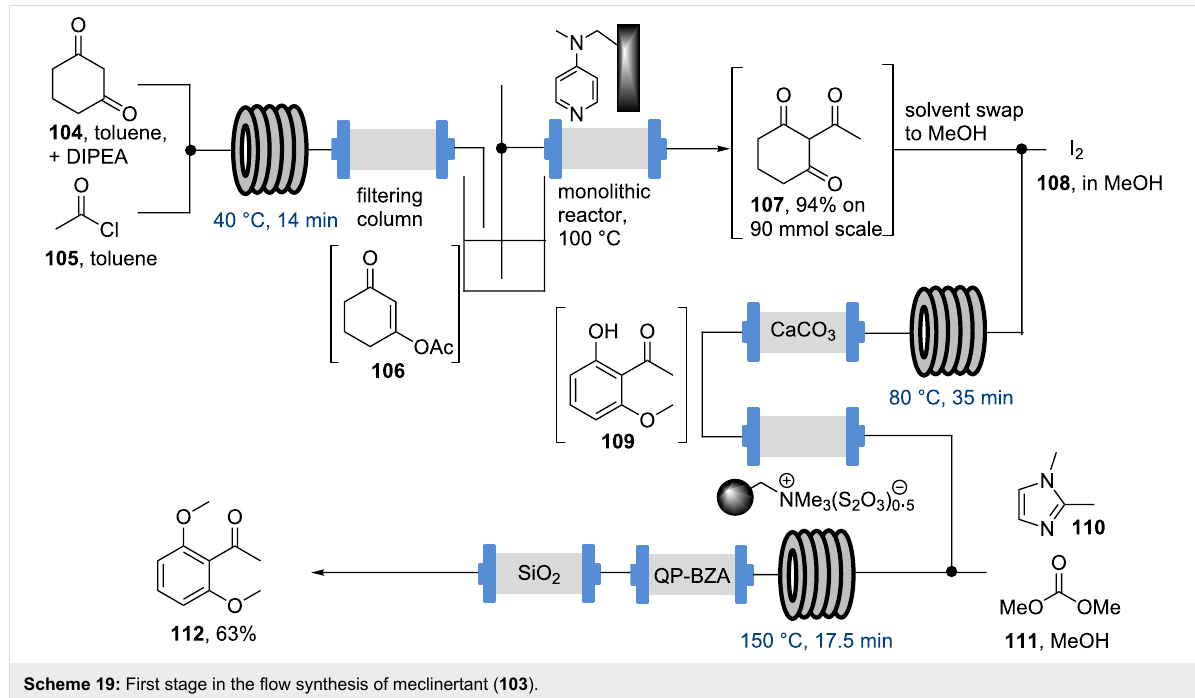
Scheme 19: First stage in the flow synthesis of meclinertant ( 103 ).